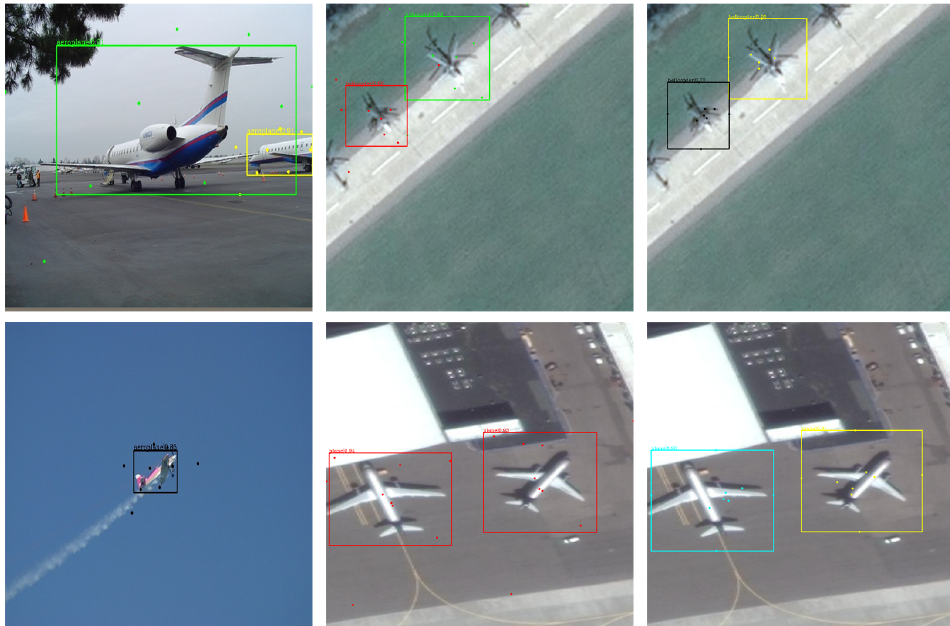
Figure 1. Visualization of reppoints and detection results, the first column is the result on the VOC dataset, the second column and the third column are the results on the DOTA dataset. The second column is the visualization result when using moment to obtain the pseudo box, and the third column is the visualization result when using